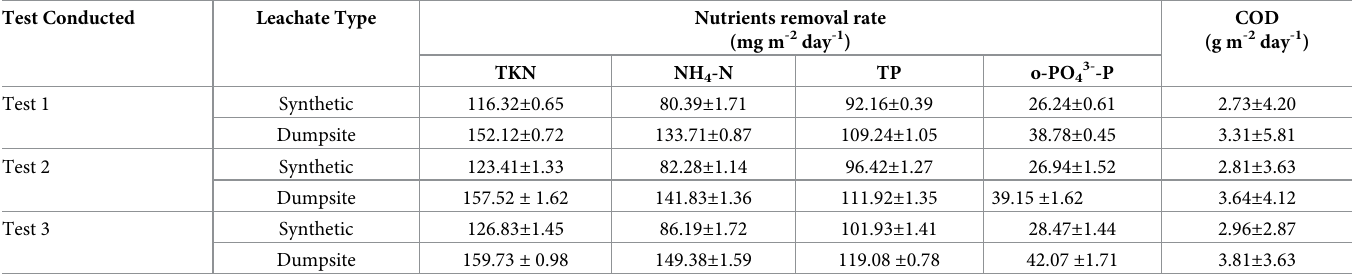
Table 5. Comparison of rates of nutrients removal and COD reduction by duckweed from synthetic and dumpsite leachate. Test Conducted